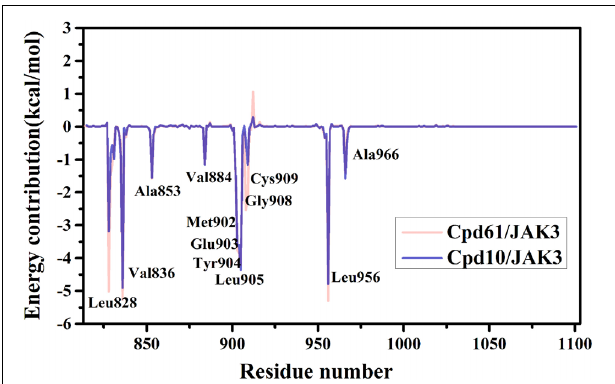
FIGURE 3 | Plot of binding-free energy decomposition on per-residue for JAK3-inhibitor